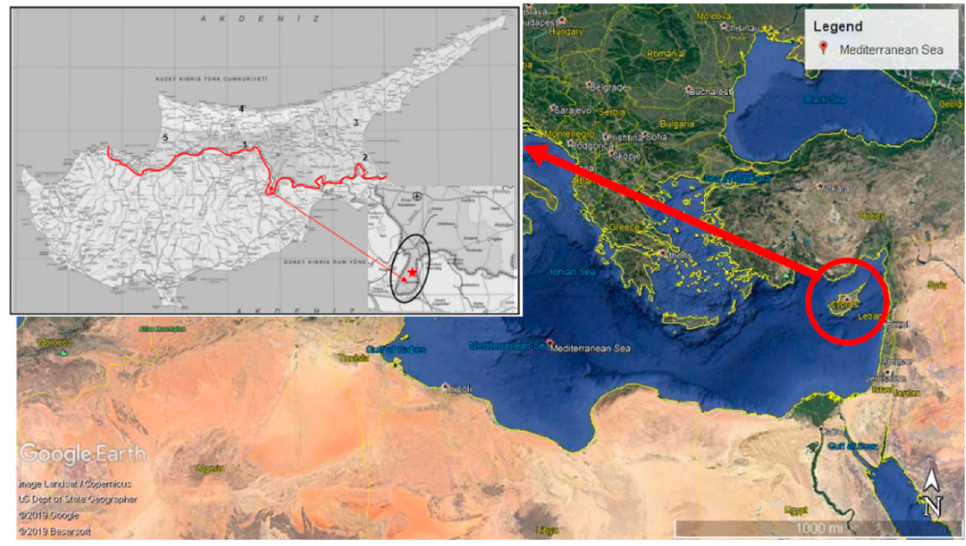
Figure 3. The Location of Louroujina Village in Cyprus [73].